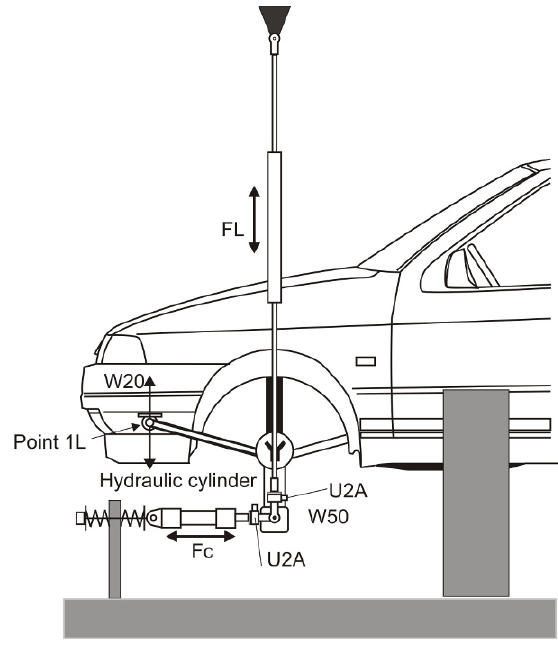
Figure 1. The left side of the car body; FC- input force realized by a hydraulic cylinder; Point 1L - left connection spot of the car body and suspension arm; FL - simulated vertical ground force reaction on the left side; U2A- force trans- ducer in horizontal and vertical direction; W50 - displace- ment transducer in horizontal direction; W20 - displace- ment transducer in horizontal